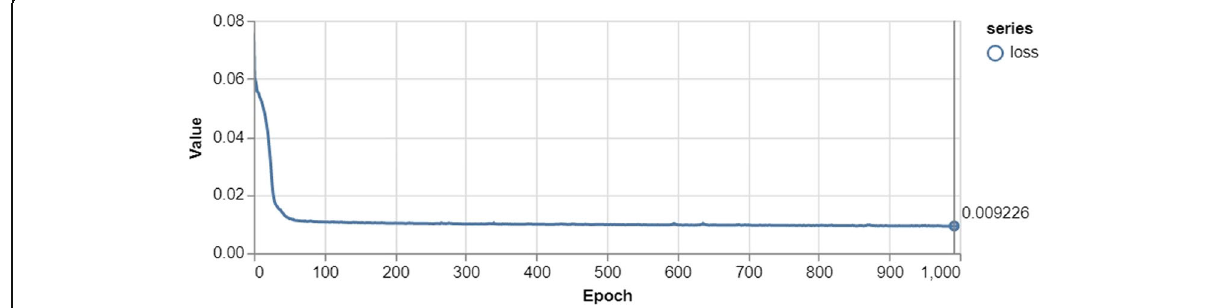
Fig. 6 Model of the performance graph